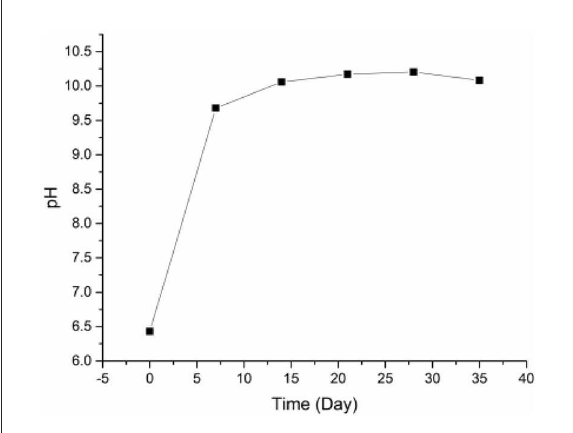
FIGURE1 The changes of pH value in preserved egg yolks during pickling.